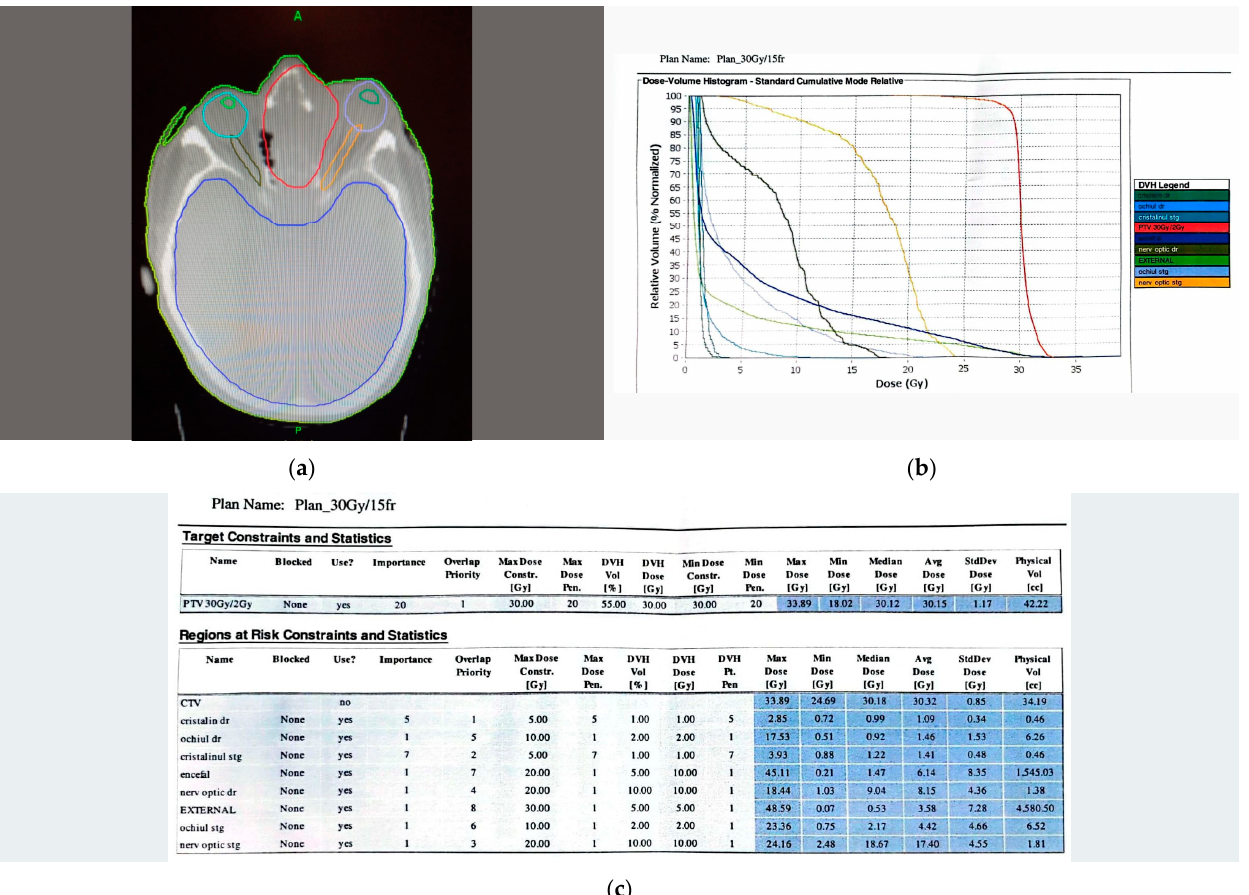
Figure 4. ( a ) Thermoplastic mask after a CT planning. The tumor mass and adjacent structures were contoured (red color). ( b ) Dose Volume Histogram. ( c ) Snapshot of the treatment plan. At three weeks of follow-up, after the radiotherapy sessions, the patient’s condition slightly improved and the IOP was normal under treatment (Figure 5). The patient remained under oncological supervision.